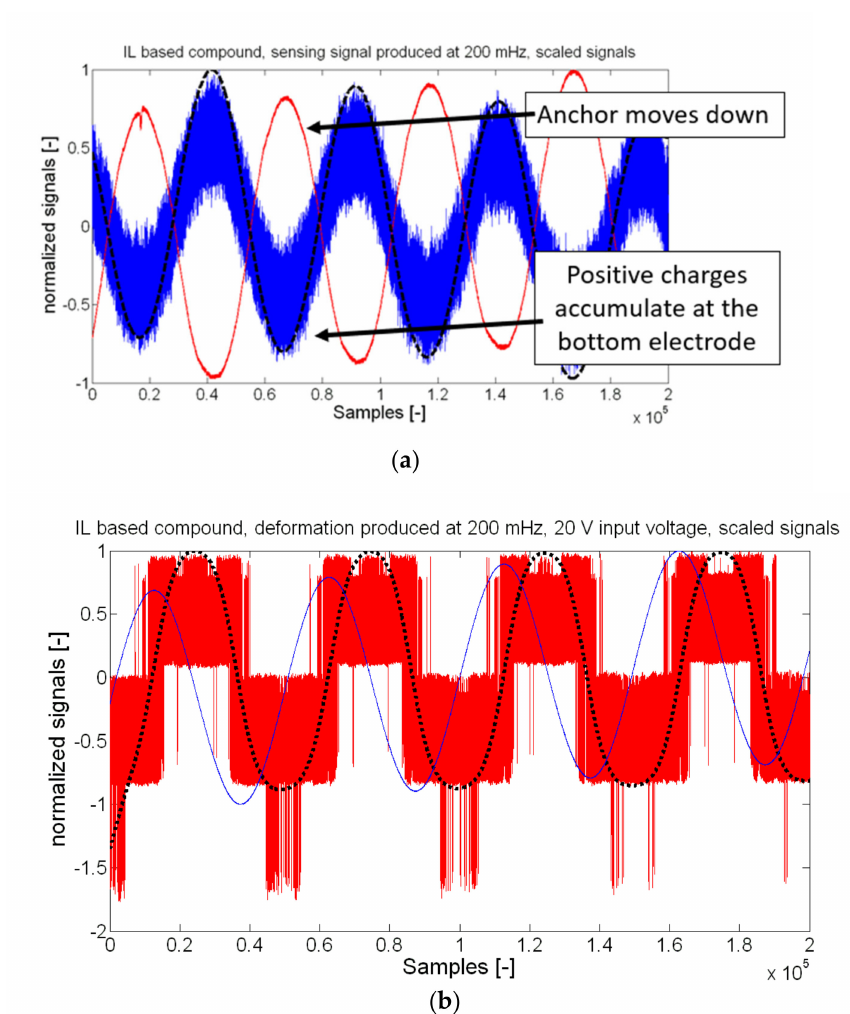
Figure 15. Comparison of signals obtained when the device is used as a sensor ( a ) and as an actuator ( b ). The dotted line indicates the filtered output signal coming from the BC ( a ) and the filtered output waveform of the laser to monitor the movement of the BC ( b